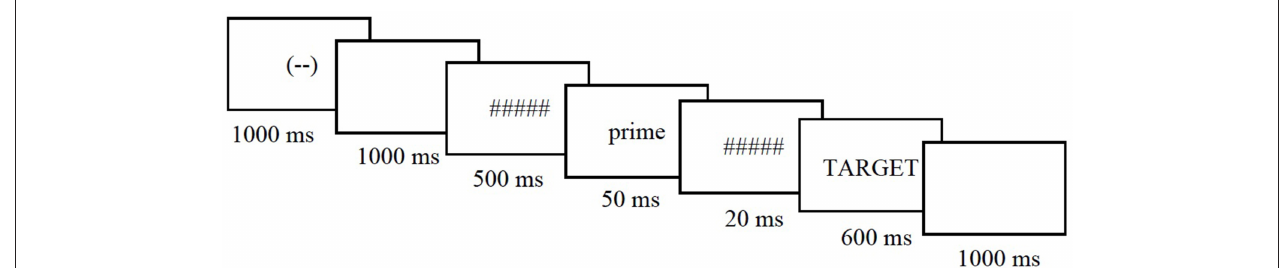
FIGURE 1 | Trial structure.